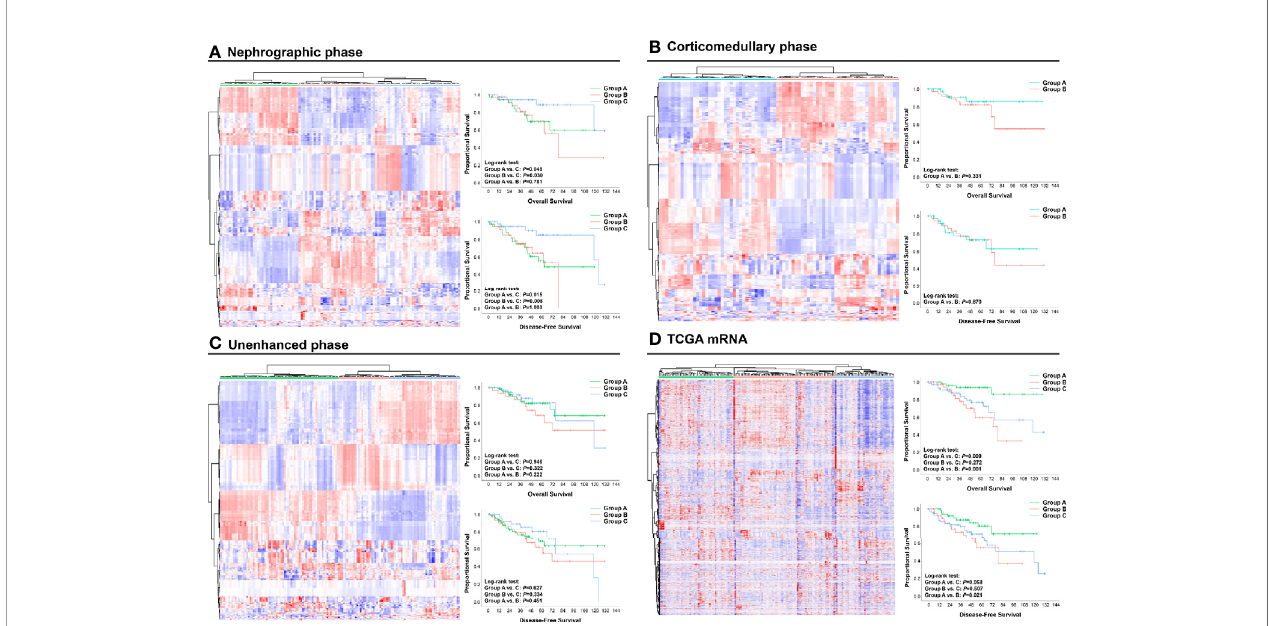
FIGURE 2 | Unsupervised hierarchical clustering analysis of radiomic and mRNA data: (A) Nephrographic phase; (B) Corticomedullary phase; (C) Unenhanced phase; (D) mRNA data. Based on the clustering results, patients were divided into different clustering groups. The OS and DFS of cases in each group are shown and compared by Kaplan – Meier curves. OS, Overall survival; DFS, Disease-free